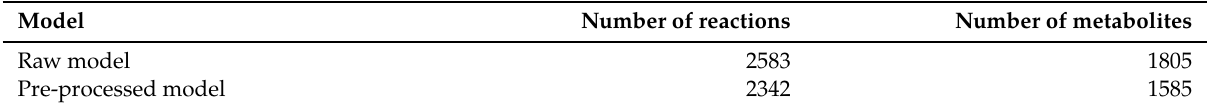
Table 2: Numbers of reactions and metabolites involved before and after the model pre-processing.